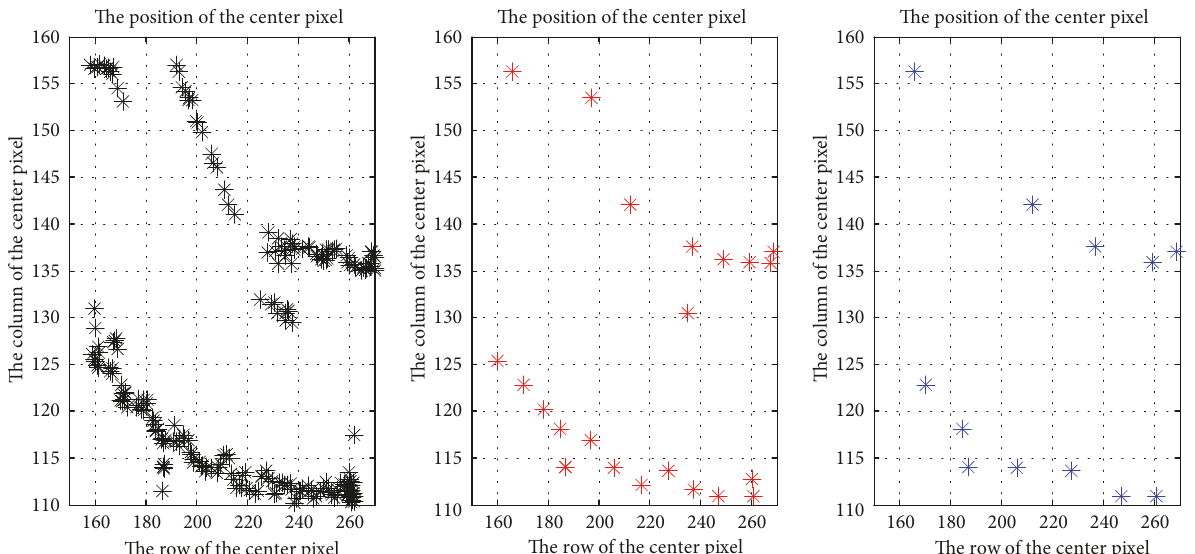
Figure 14: Target trajectory of the center pixel corresponding to sequence S2. From left to right, 𝜐 = 1 , 𝜐 = 10 , and 𝜐 = 20 .